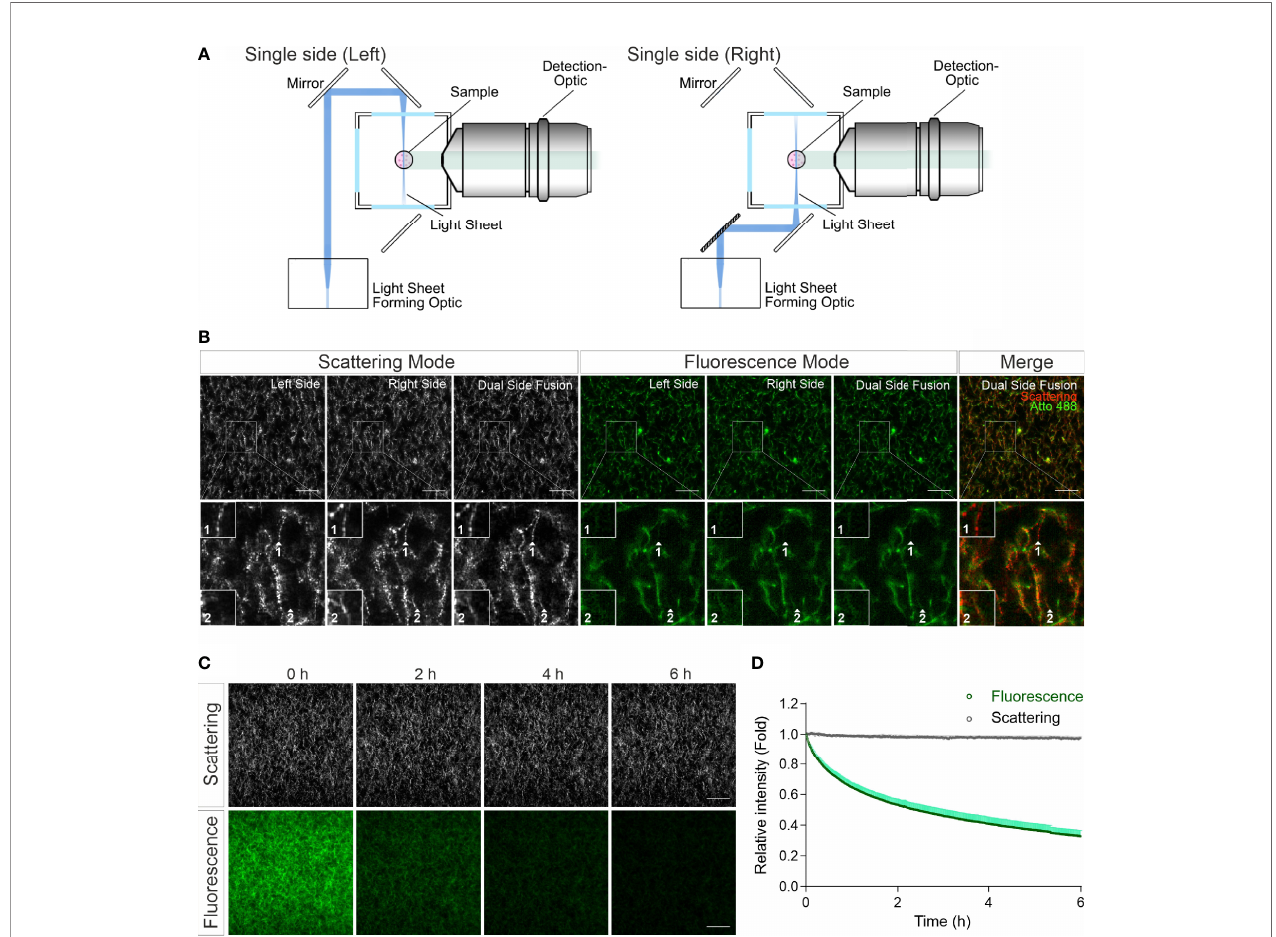
FIGURE 2 | LSSM avoids photobleaching and blind spot problems. (A) Sketch for single side illumination. (B) Comparison of images acquired by LSSM and fl uorescence microscopy. Rat tail collagen (2 mg/ml) was fl uorescently labeled with Atto 488. Images from single side illumination and the merged images of both sides (dual side fusion) are shown. Z-stacks with step-size of 1 µm for 51 slices were obtained with LSSM and fl uorescence mode concurrently at 37°C. (C, D) Signal intensity obtained by LSSM is not reduced with time. Bovine collagen (2 mg/ml) was labeled with Atto 647. Z-stacks with step-size of 0.621 µm for 50 slices were obtained with LSSM and fl uorescence mode subsequentially at 37°C every 30 sec for 6 hours. Scale bars are 40 m m. Quanti fi cation is shown as Mean ± SEM. Representative images from at least three independent experiments are